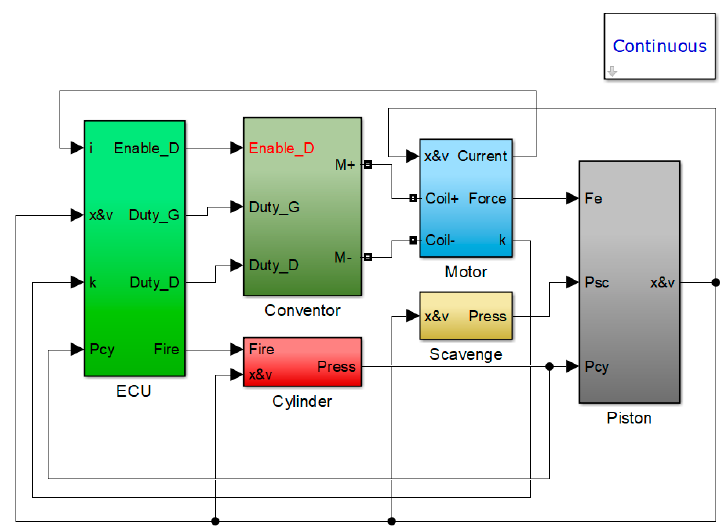
Table 2. The initial simulation parameters.